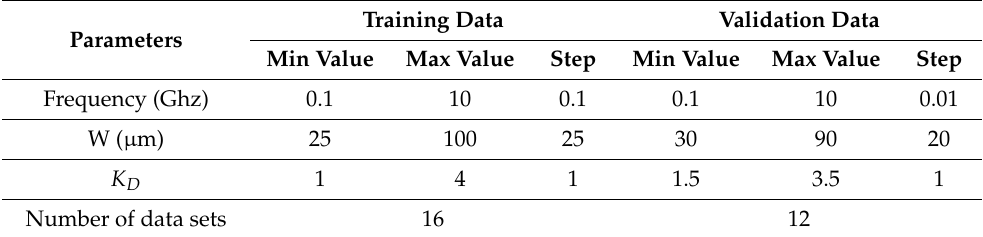
Table 1. Training and validation data information in microstrip line structure.